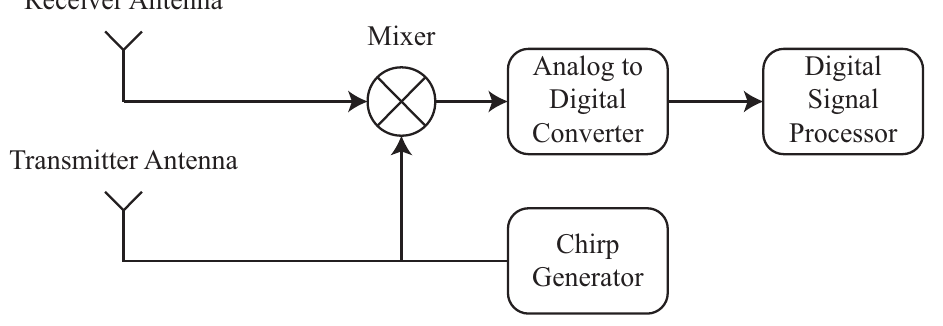
Figure 1. Basic scheme of FMCW